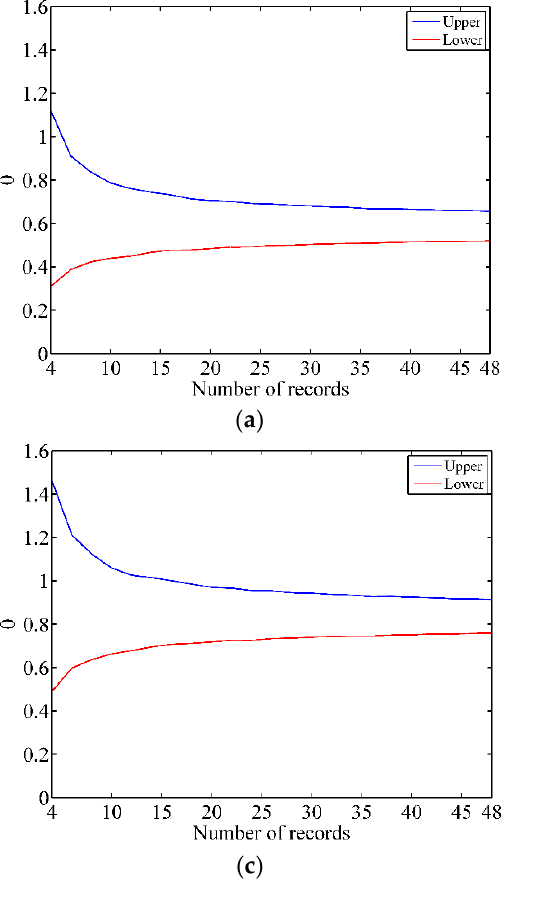
Figure 10. The lower and upper 95% confidence interval for estimated θ and β with different number of records: ( a , b ) for parked condition, and ( c , d ) for normal operation condition.